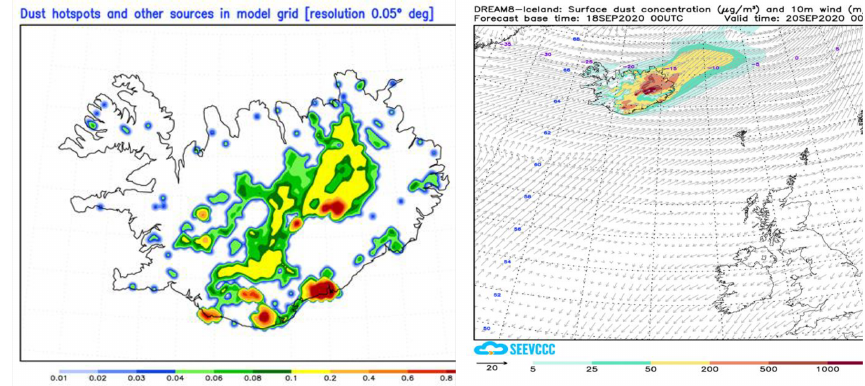
Figure 11. Left panel: dust sources in the DREAM-ICELAND model grid with areas vulnerable to erosion and containing hotspots (Arnalds et al., 2016). Right panel: an example of the operational Icelandic dust surface concentration forecast for 18 September 2020 (available at the Republic Hydrometeorological Service of Serbia site, http://www.seevccc.rs/?p=8, last access: 17 August